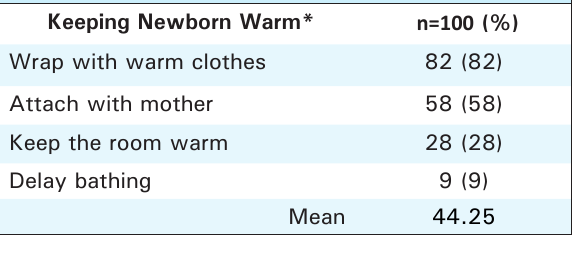
Table 4. Knowledge on Keeping the Newborn